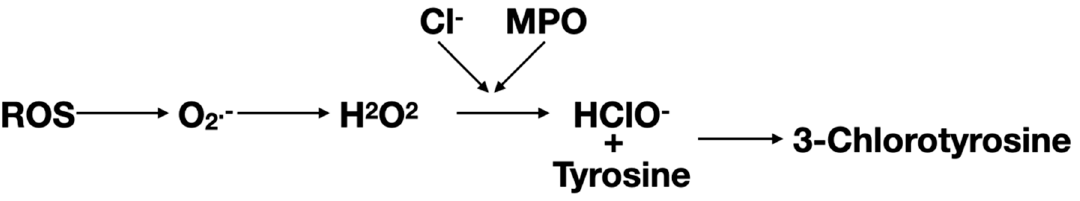
Figure 2. Hypochlorous acid is formed from hydrogen peroxide and chloride anion by MPO as a catalyst. MPO catalyses the transformation of hydrogen peroxide (H 2 O 2 ) and chloride anion (Cl − ) into highly reactive hypochlorous acid. 3-ClTyr is a product resulting from the combination of HOCl and p -tyrosine.